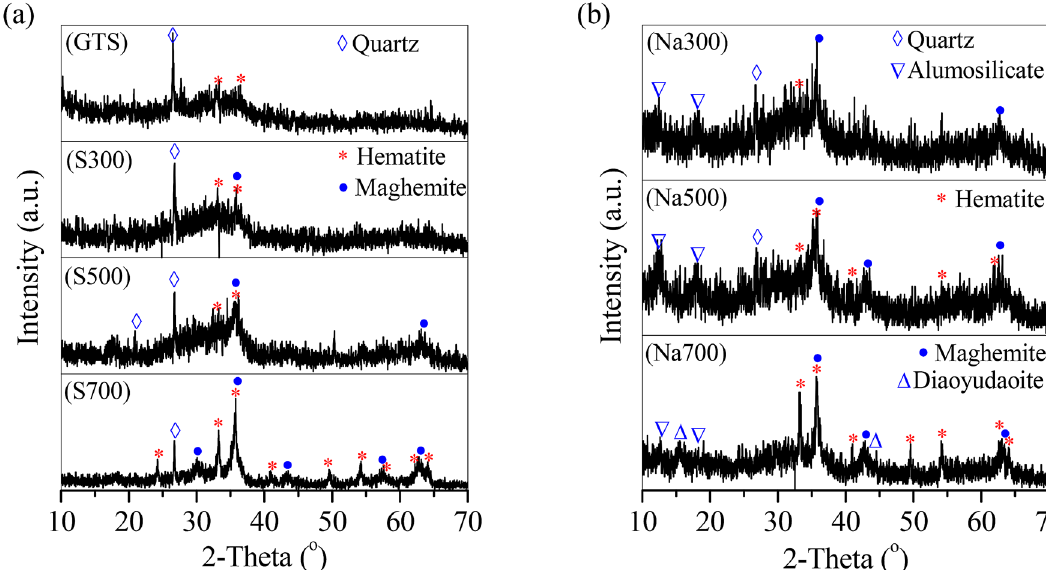
Figure 2. XRD curves of the GTS and prepared adsorbents.